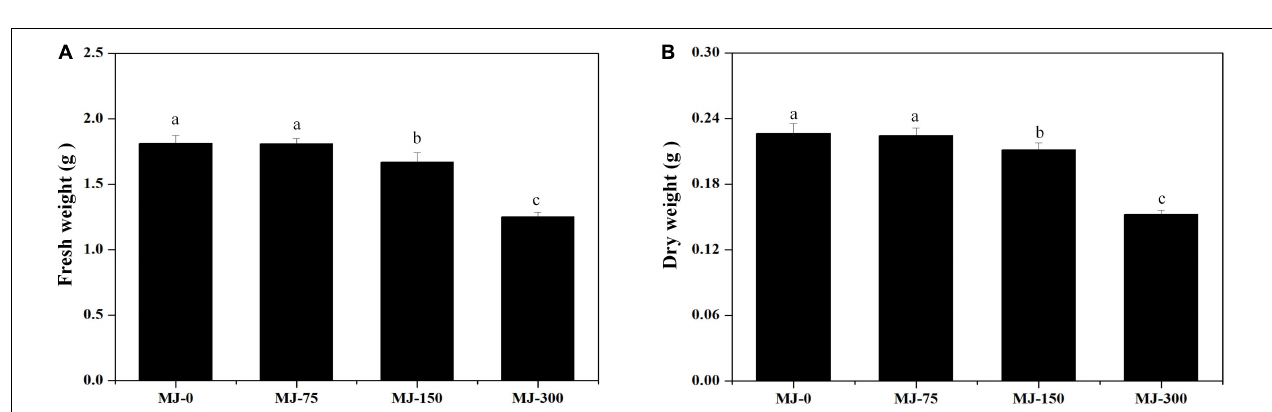
FIGURE 2 | The biomass of L. longituba seedlings grown under different MeJA treatments. (A) The fresh weight of L. longituba seedlings grown under different MeJA treatments. (B) The dry weight of L. longituba seedlings grown under different MeJA treatments. Error values indicate the standard deviation (SD). Least-significant difference test (LSD, p < 0.05) was used to compare the me9.ans. Different letters represent significant differences between groups ( N = 3, p < 0.05).